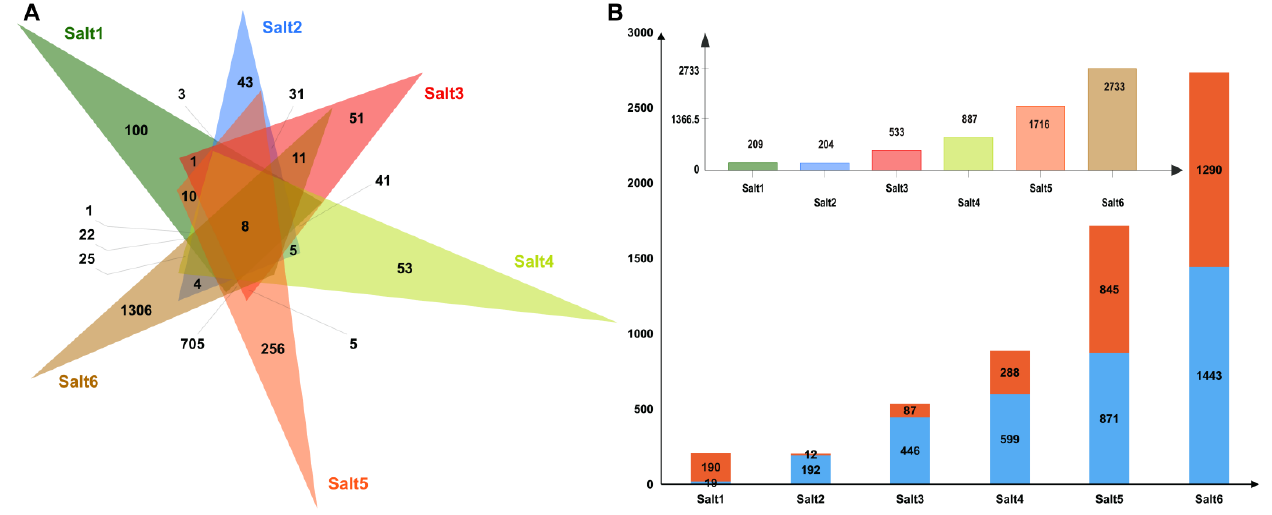
Figure 4. Transcriptomic analysis. ( A ) All DEGs are expressed in different colors in the six different stages of salt stress. ( B ) Upregulated and downregulated DEGs in the six periods. The blue box above represents the downregulated DEGs, and orange represents the upregulated DEGs.